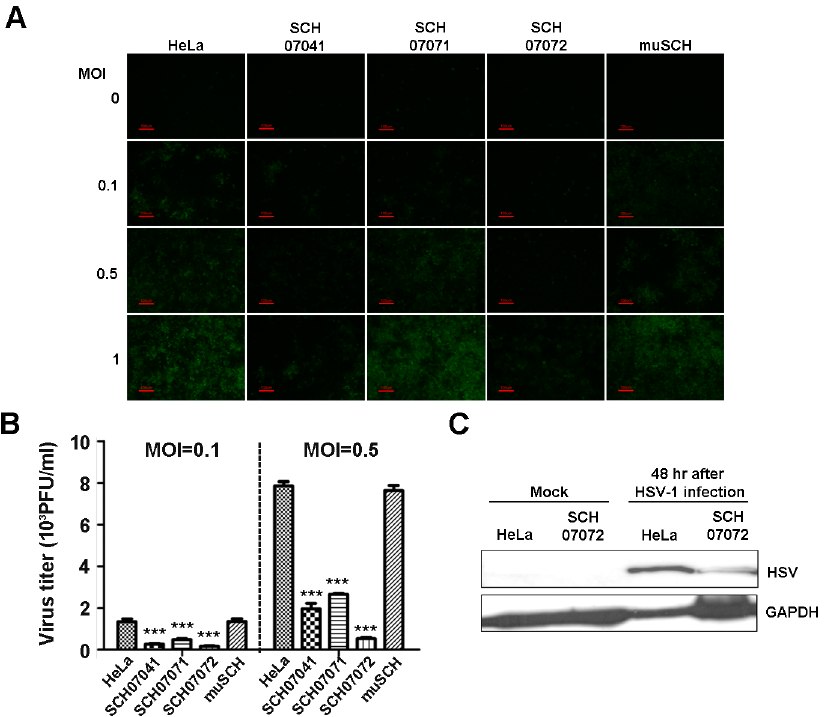
Figure 2. 3D8 scFv expression in transgenic HeLa cells confers resistance to HSV infection. A . Three 3D8 scFv cell lines and one mutant 3D8scFv cell line were challenged with HSV::GFP at different MOIs (0.1, 0.5, and 1). The SCH07072 line showed the lowest GFP expression compared to that of the other lines (SCH07041, SCH07071, and muSCH). B . Wild-type HeLa, SCH07072, and muSCH cells were infected with HSV::GFP at 0.1 and 0.5 MOI. Plaque assays revealed that SCH07072 cells had the lowest amount of virus progeny (0.1 MOI: HeLa=1,343.33 6 139.68, SCH07041=266.67 6 31.80, SCH07071=483.33 6 43.72, SCH07072=163.33 6 29.06, muSCH=1,356.67 6 131.70; 0.5 MOI: HeLa=7,851.00 6 209.10, SCH07041=1,964.00 6 263.04, SCH07071=2,649.67 6 49.02, SCH07072=530.67 6 55.68, muSCH=7,646.67 6 233.90). Data bars show mean 6 standard error. *** indicate significant differences from HeLa cells at p , 0.001 (one-way analysis of variance and Tukey’s post hoc t -test). C . Western blot analysis using an anti-HSV DNA polymerase antibody demonstrated that less HSV DNA polymerase protein was present in SCH07072 cells compared to wild type HeLa cells 48 hr after virus challenge.